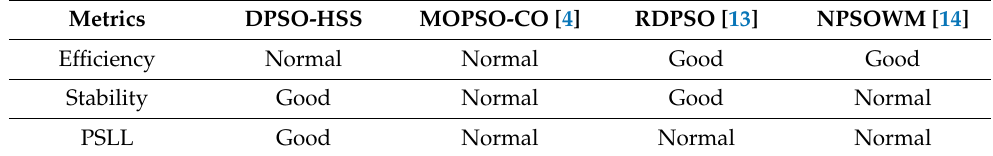
Table 4. Comparison of the proposed algorithm and other algorithms in key performance